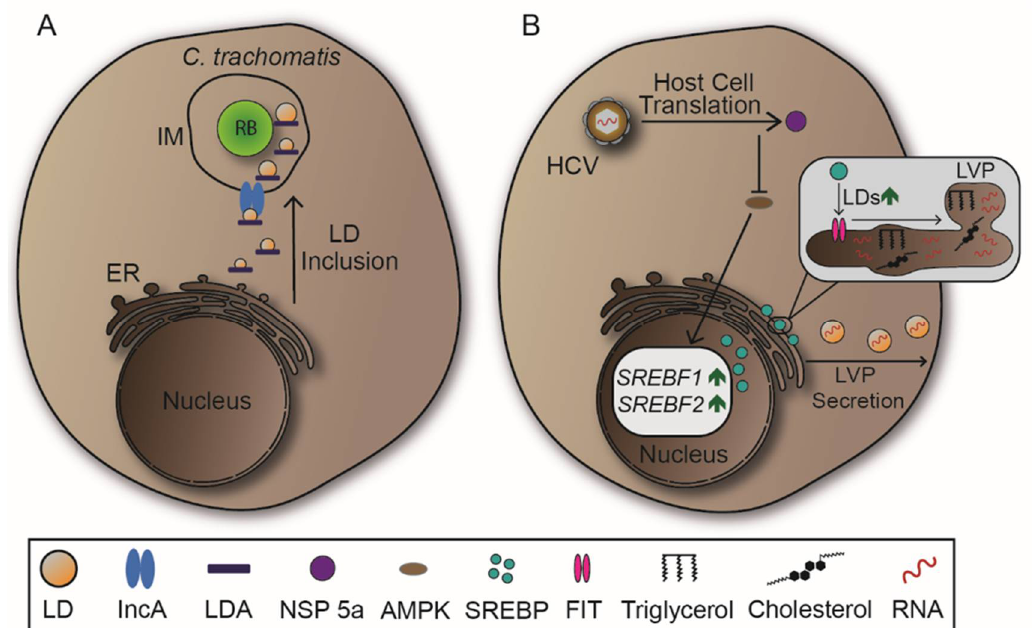
Figure 8. Manipulation of lipid droplets (LDs) by Chlamydia trachomatis and Hepatitis C virus (HCV). ( A ) C. trachomatis redirects LDs originating from ER to the inclusion membrane through expression of lipid droplets-associated proteins (LDA) and inclusion membrane protein A (IncA). IncA mediates homotypic fusions at the inclusion membrane (IM) and is suggested to mediate the same effect on LDs. Specific LDA functions are yet to be unravel. ( B ) HCV exploits host cell translation machineries to synthesize non-structural protein (NSP) 5a which inhibits phosphorylation and therefore activation of regulatory enzyme adenosine monophosphate-activated protein kinase (AMPK). Subsequently, expression of genes encoding lipid metabolism regulator sterol regulator element-binding protein (SREBP) are increased, leading to higher biogenesis of LDs. HCV uses LDs to distribute its RNA throughout the organism as lipoviroparticles (LVPs) that can be secreted by cells to promote viral spread.